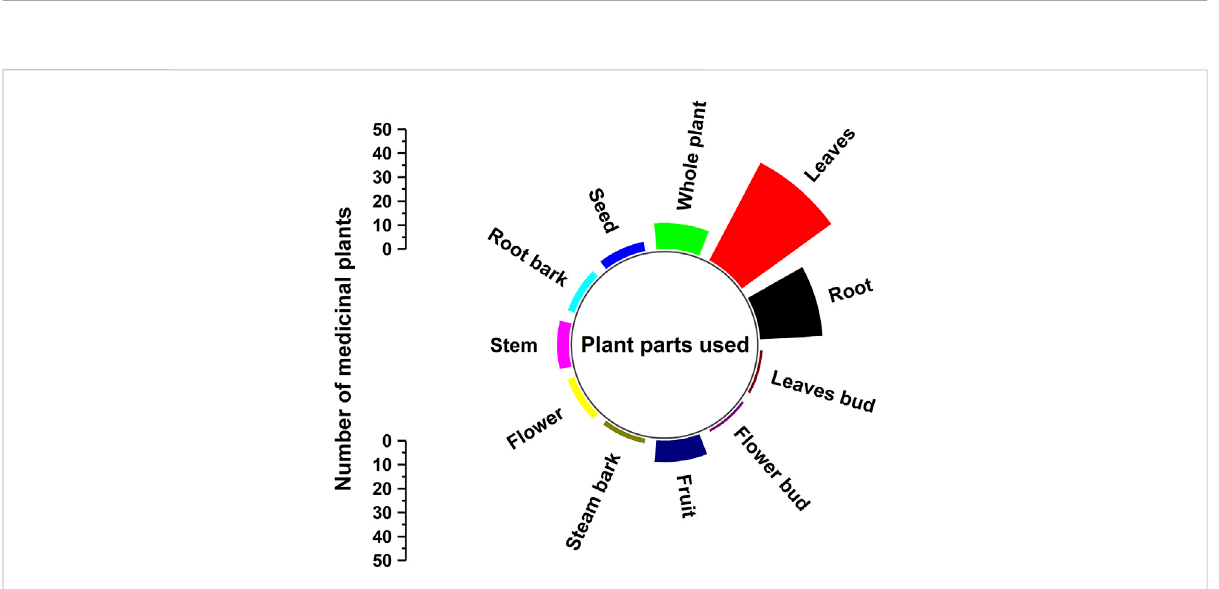
FIGURE 5 Plant parts used in for traditional medicine. The fi gure depicts the different part of the plants used by the traditional healers at Gullele Botanical Garden for preparing the traditional medicine and the number of